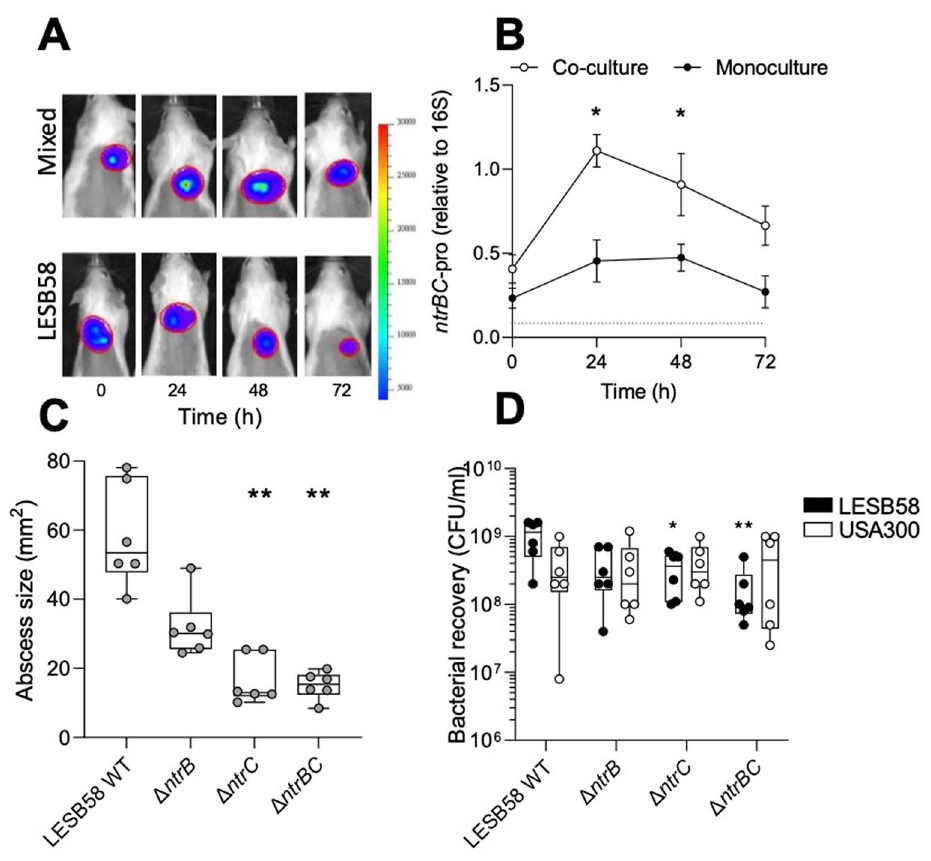
Figure 5. P. aeruginosa LESB58 ntrBC promoter activity was induced during co-culture in vivo and Δ ntrC and Δ ntrBC mutants were modestly outcompeted by S. aureus USA300 LAC. Bacteria were inoculated in the right dorsum of mice and ( A,B ) luminescence due to the expression of the lux -fused ntrBC promoter was ( A ) imaged with an in vivo imaging system (IVIS) and ( B ) quantified relative to 16S rRNA promoter activity. After euthanasia ( C ) abscess size was measured using a calliper and (D) live bacteria were enumerated following homogenization, plating on selective media, and overnight growth at 37ºC. Data are presented as mean ± standard error of the mean (SEM), and box plots delineate the interquartile range for data from three independent experiments containing two biological replicates in each ( n = 6). ( B ) * P < 0.05, ** P < 0.01 different from mono-species infection according to paired t-test. ( C ) ** P < 0.01 different from mixed abscesses formed with LESB58 WT according to Kruskal–Wallis test followed by Dunn’s correction. ( D ) * P < 0.05, ** P < 0.01 different from LESB58 WT recovered from mixed abscesses according to two-way Kruskal Wallis test followed by Dunn’s